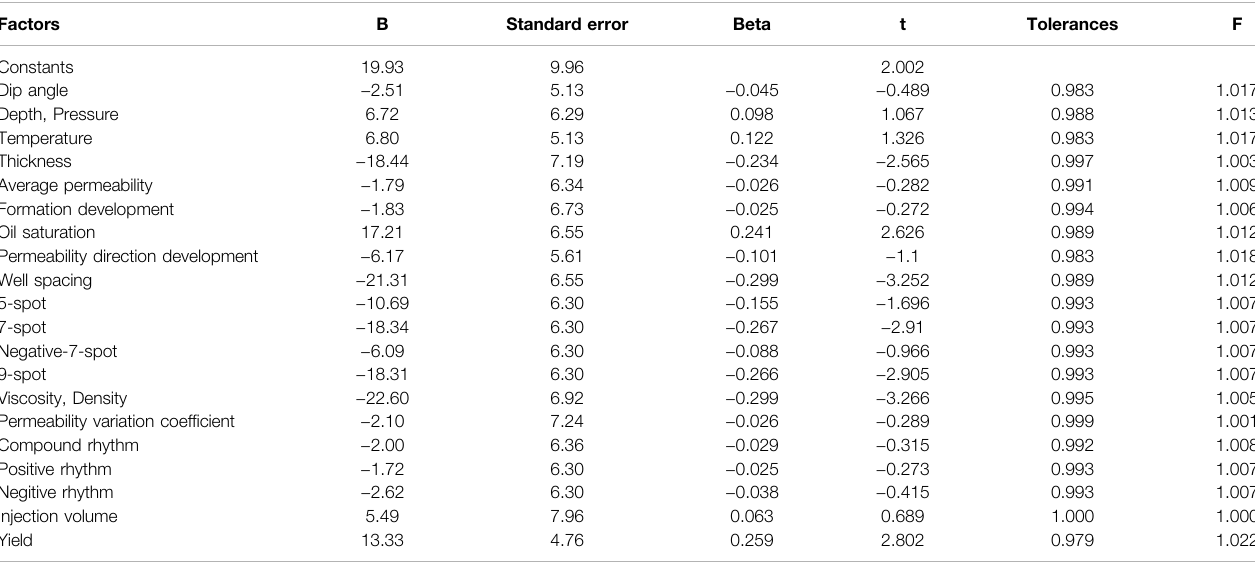
TABLE 3 | Multiple linear regression table for CO 2 fl ooding in the Daqing low-permeability reservoir. Factors B Standard error Beta